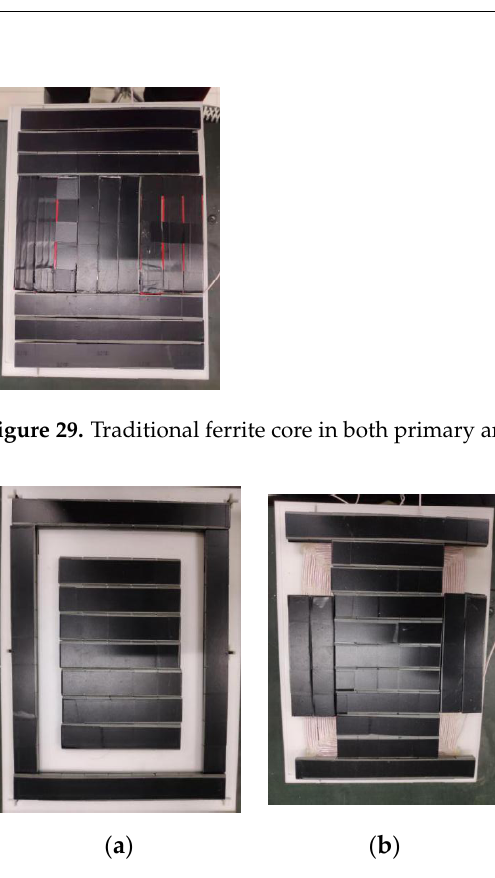
Figure 30. Optimized ferrite structure: ( a ) Primary core; ( b ) Secondary core. Table 7. Design and experiment parameters of the traditional square couplers.